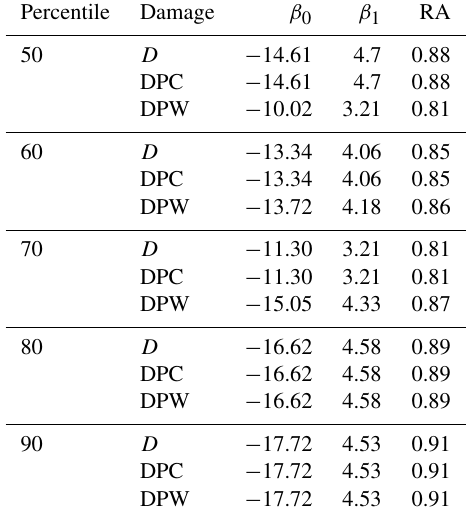
Table 4. Parameters of the logistic model and RA values for the MAB level with 10mm30min − 1 maximum precipitation thresh- old. All the results are significant ( p value < 0 . 05). Number of flood cases: 38.